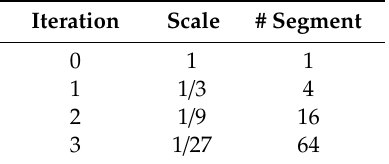
Figure 4. Generation ( a ) and generalization ( b ) of the Koch curve with the first four iterations (Note: Beginning with a segment of scale 1 (n = 0), it is divided into thirds, and the middle third is replaced by two equilaterals of a triangle, leading to four segments of scale 1 / 3 (n = 1). This division and replacement process continues for scales 1 / 9, and 1 / 27, leading respectively to 16 segments, and 64 segments (n = 2, and 3). This is the generation of the Koch curve, as shown in panel ( a ). On the other hand, the Koch curve (Level 0) can be generalized in a step-by-step fashion, as shown in Table 3, resulting in the outcome in panel ( b )). Table 3. The four iterations of the Koch curve as shown in Figure